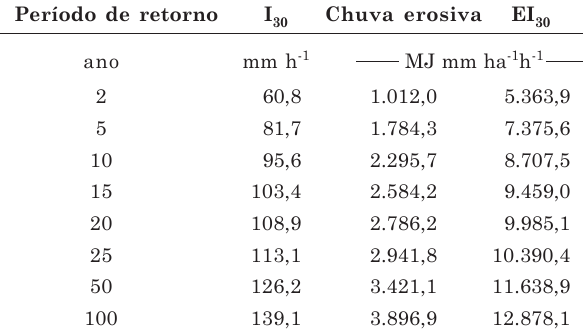
Quadro 4. Intensidade máxima em 30 min (I 30 ), chuva erosiva máxima anual e índice de erosividade anual (EI 30 ) estimados para diferentes períodos de retorno para Urussanga,